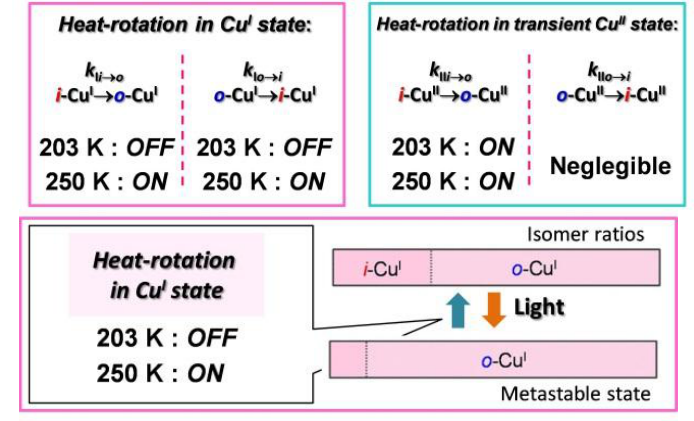
Figure 6. Conceptual diagram summarizing the rotation kinetics described in this